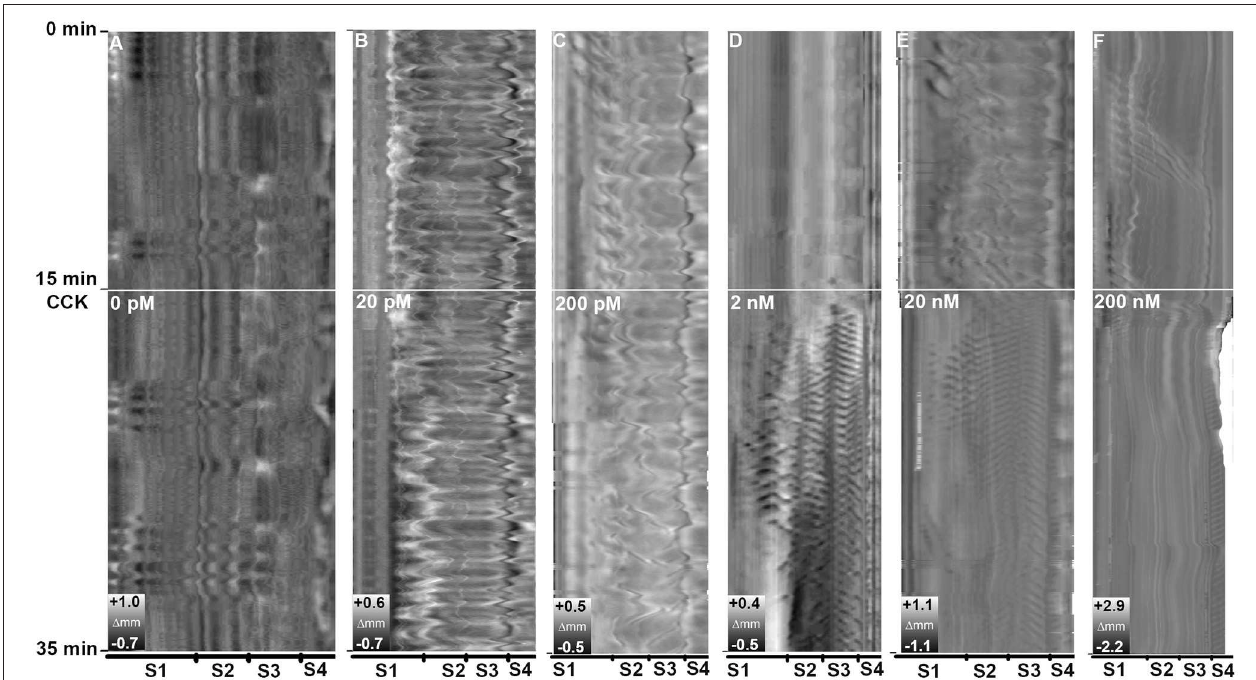
FIGURE 8 | Effects of concentration CCK-8S on motility in ballan wrasse intestine. (A) control without adding CCK-8S to the medium; Intestine was exposed to CCK-8S in the medium at concentration at (B) 20 pM, (C) 200 pM, (D) 2nM, (E) 20nM, and (F) 200nM. The white line marks when CCK was added to the medium. Each concentration has three replicates and the figure shows an example from the Experiment